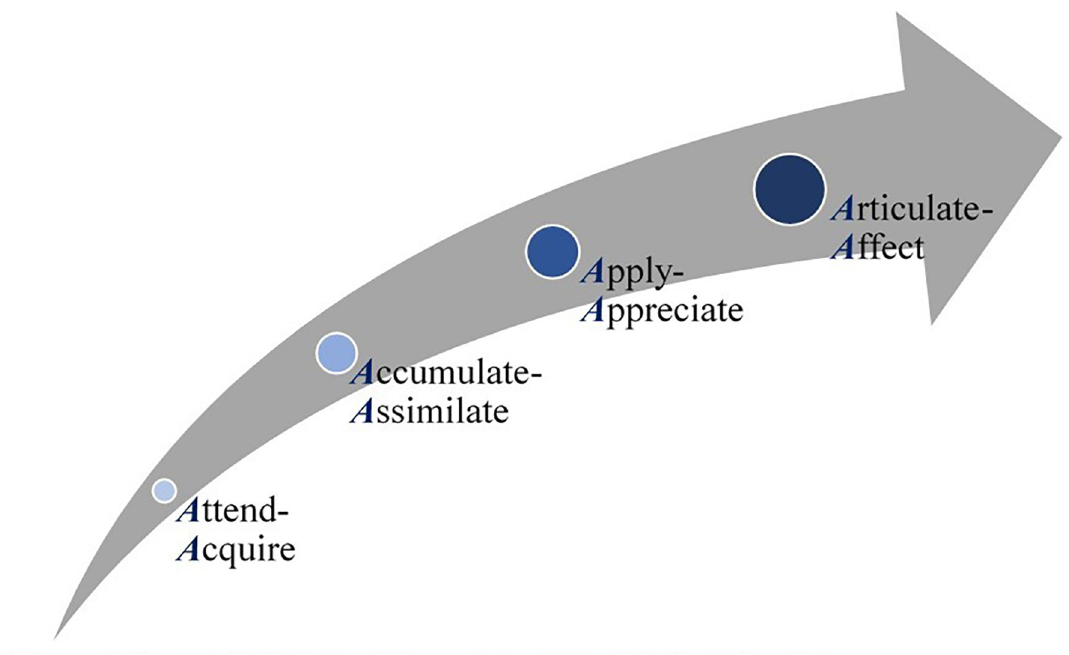
Fig 1. Sequential steps of the research module learning journey. The qualitative component of this mixed methods research study generated this framework, depicting the different phases that students go through as part of the curriculum-based research module (represented as the Grey arrow). Each phase, representing a theme of the inductive analysis, appeared to be characterized by an interplay of two verbs. Hence, the code mindfully ascribed to each theme brings together two verbs, each starting with the letter ‘A’. The increasing size of circles represent the students’ accumulation of expertise (ie integrated knowledge and skills), and the color development (ie from light to dark) represents the gradual evolution that the students go through, over time.